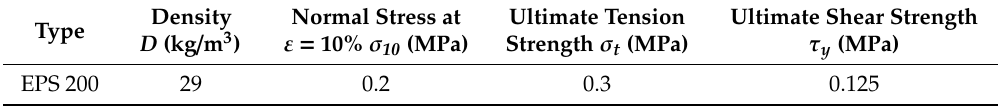
Table 7. Mechanical properties of TRM